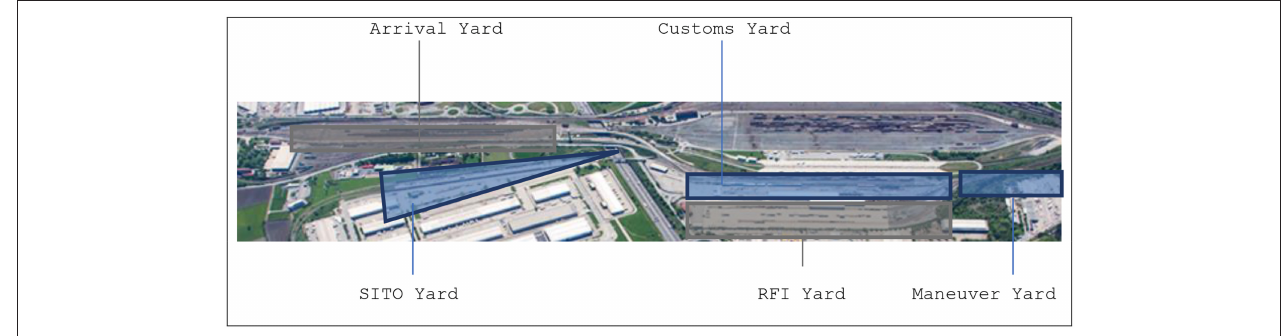
FIGURE 1 | The layout in the Freight Village of